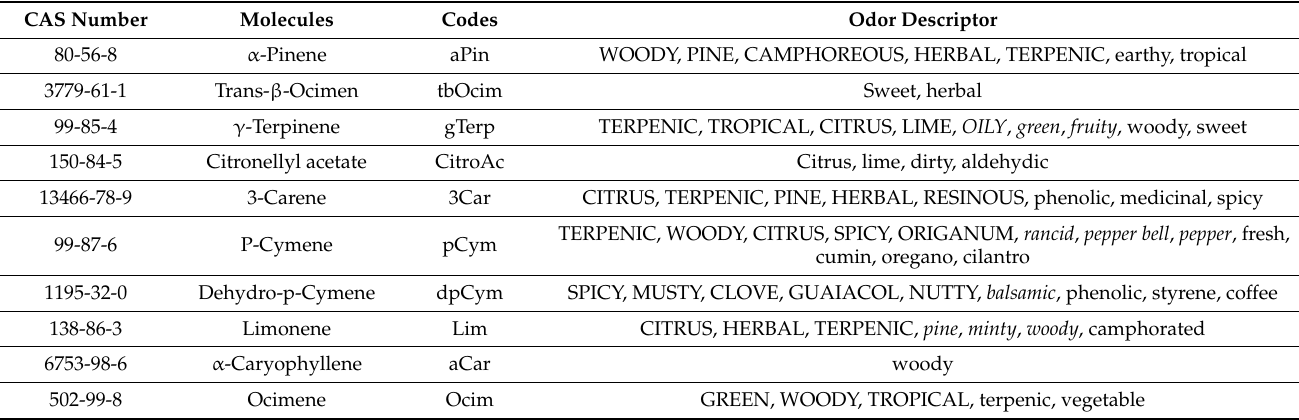
Table 4. List of the 20 molecules involved in the fingerprint of Noir de Bourgogne and measured in the